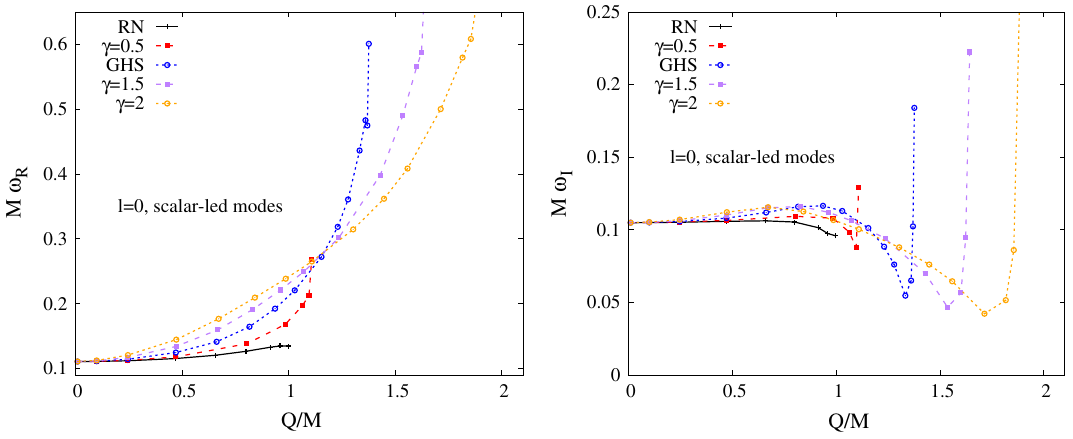
Fig. 2 Scalar-led modes for radial l = 0